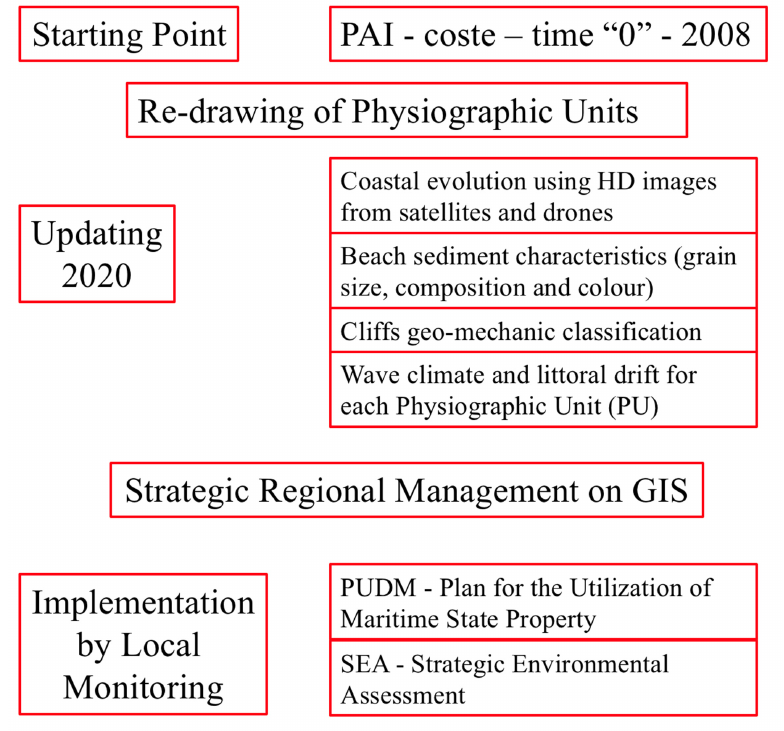
Figure 4. Flow chart of the proposed coastal plan against coastal erosion.